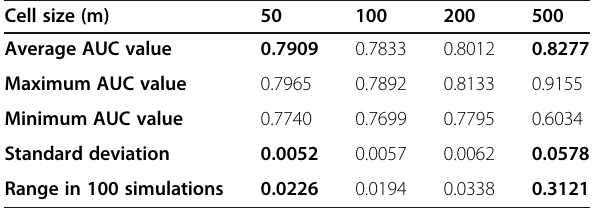
Table 7 Descriptive statistics of AUC values of LSM with LR for Quito for 100 simulations for cell sizes of 50, 100, 200, and 500 m Cell size